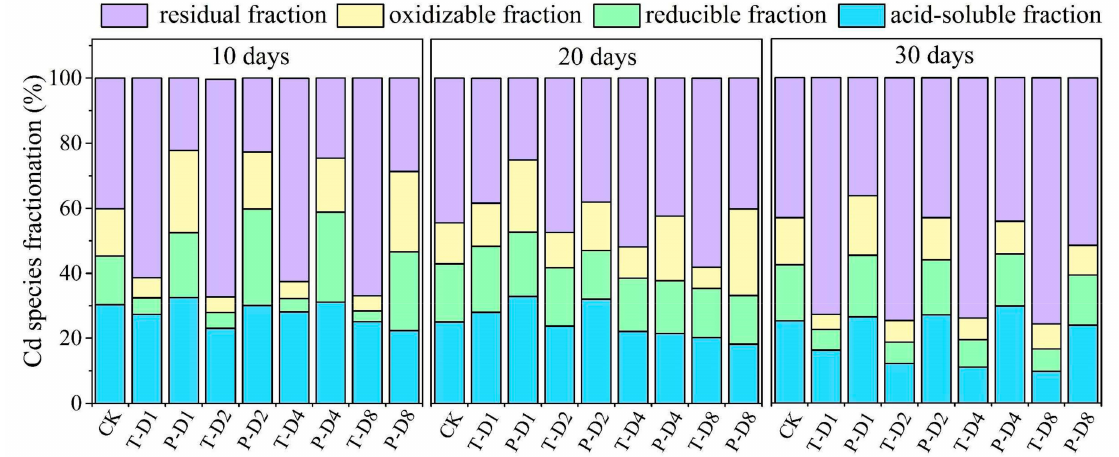
Figure 3. Influence of PBC600 and TPBC600 on distribution of Cd species. Note: T stands for TPBC600; p stands for